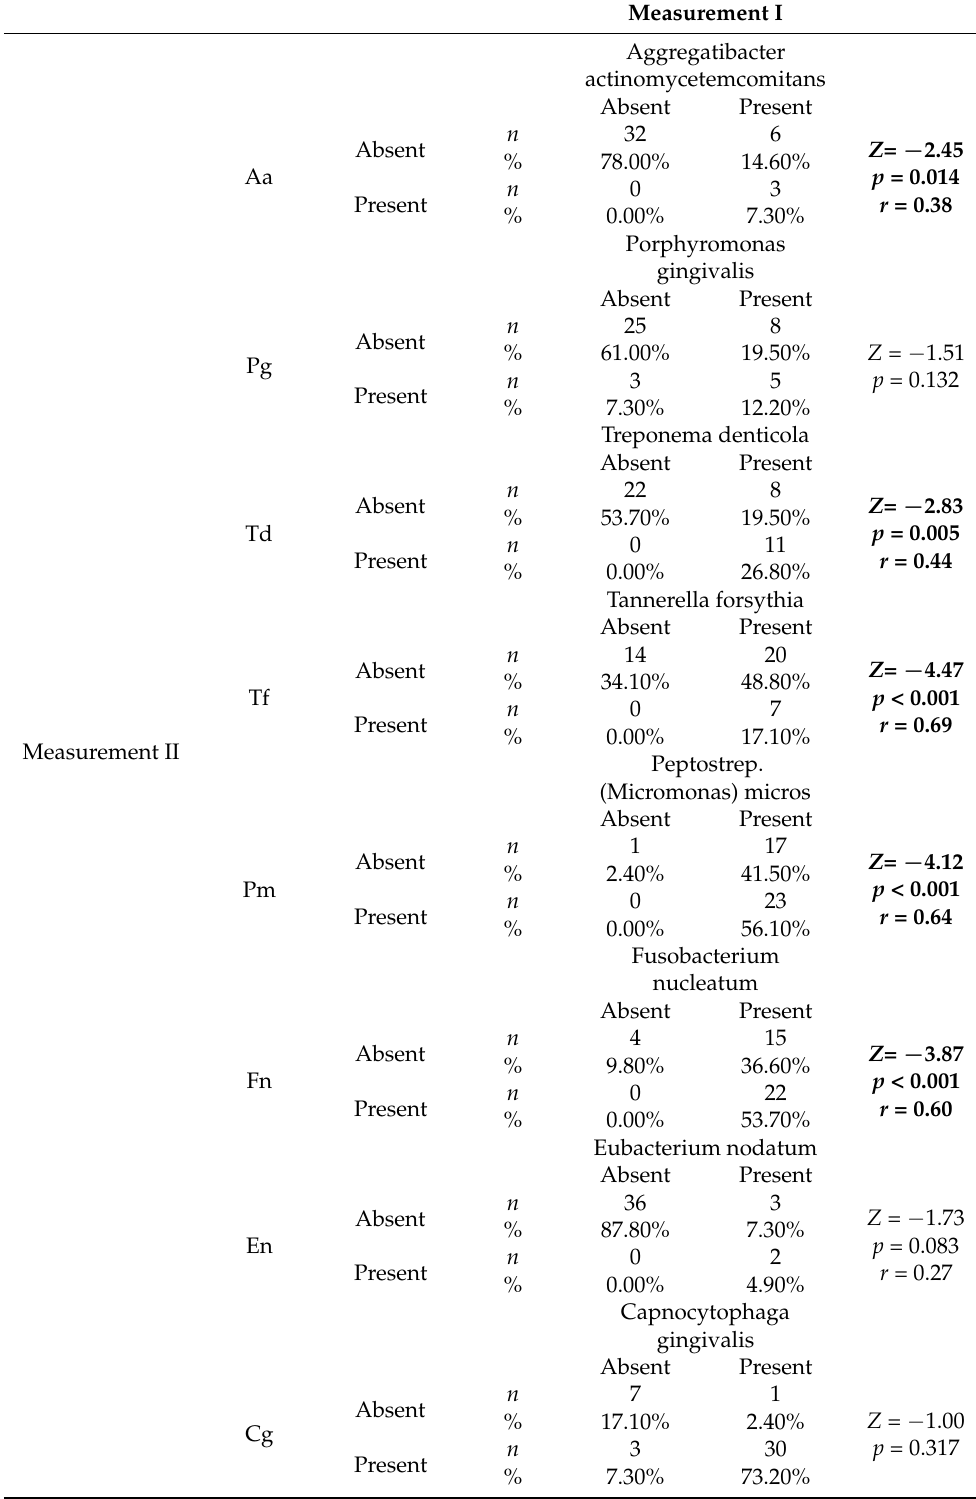
Table 4. Occurrence of bacteria strains before (measurement I) and after treatment (measurement II) with a bioactive healing abutment containing